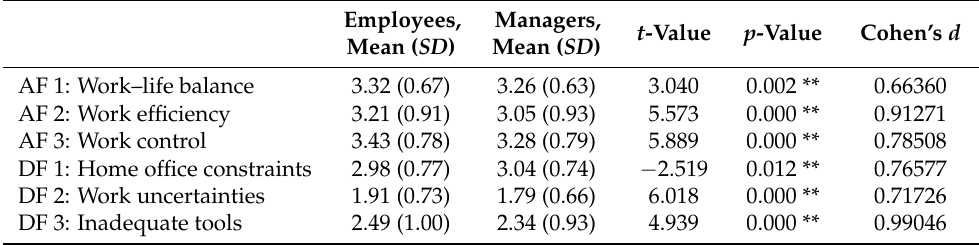
Table 7. Results of the t -tests for employees and